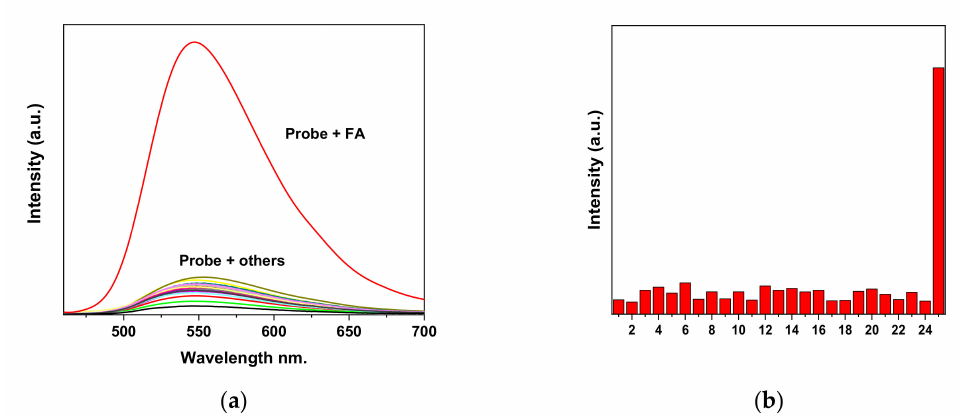
Figure 2. The selectivity of probe EW2 (10 µ M) against various analytes (50 µ M): ( a ) fluorescence spectra and ( b ) a bar graph of the fluorescence intensities at 547 nm for (1) the probe alone, (2) Br − , (3) Cl − , (4) F − , (5) I − , (6) NO 2 − , (7) NO 3 − , (8) SCN − , (9) OAc − , (10) HSO 3 − , (11) OH − , (12) t- BuO − , (13) OCl − , (14) O 2 , (15) H 2 O 2 , (16) HS − , (17) Cys, (18) Hcys, (19) GSH, (20)